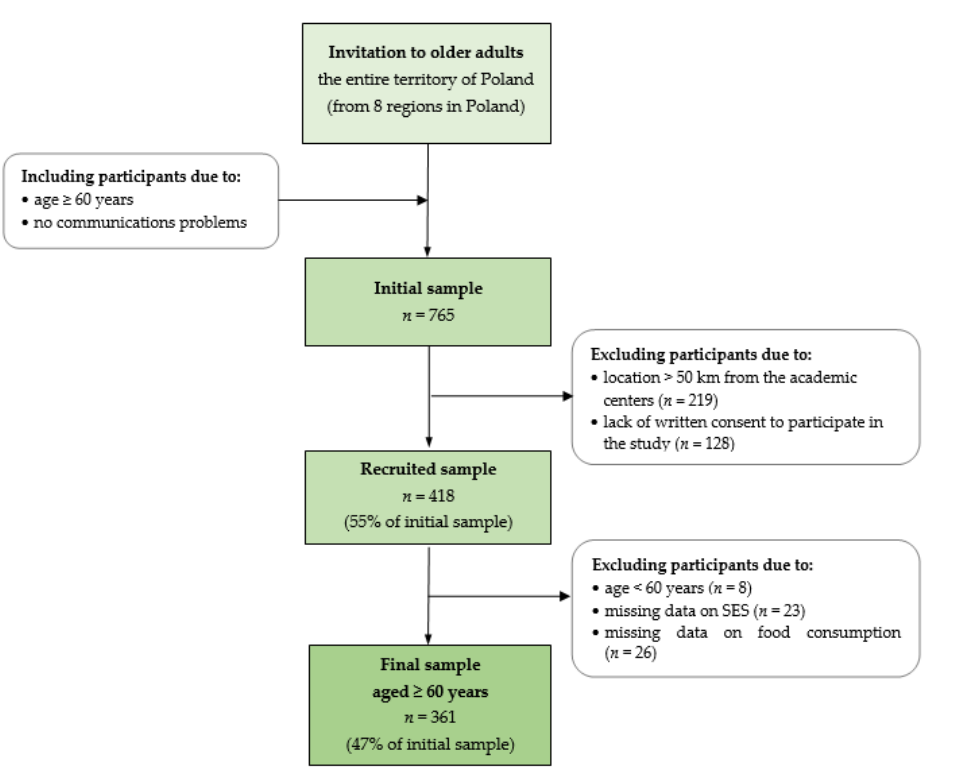
Figure 1. Flowchart of study design and sample collection. Note: SES—socioeconomic status.